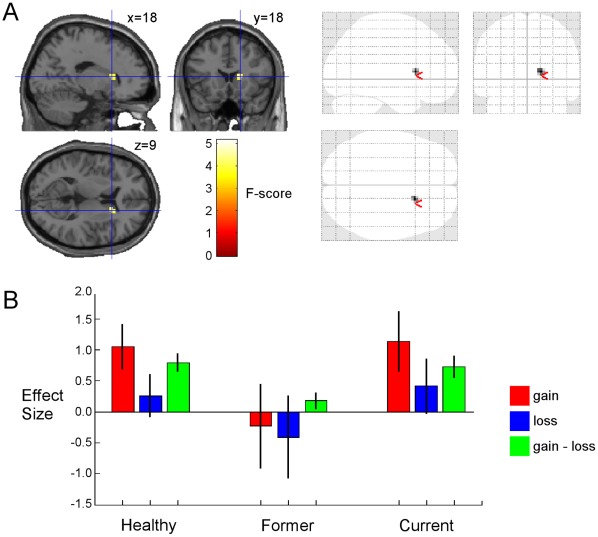

A. Statistical parametric F-maps (sagittal, coronal and axial) of the Gain-Loss contrast for one-way ANOVA between-group main effect (masked with the Reward mask).Crosshairs overlaid on brain slices are at located at x,y,z  = 18,18,9 (peak voxel). Glass brain at top right shows that the cluster in the right dorsal caudate is only surviving cluster. Threshold was set at p<0.05 uncorrected, minimum cluster size k = 10 voxels. B. Effect sizes for Gain (red), Loss (blue) and Gain-Loss (green) contrasts for HC, FCD and CCD groups at x,y,z  = 18,18,9. Black bar represents standard error of the mean.